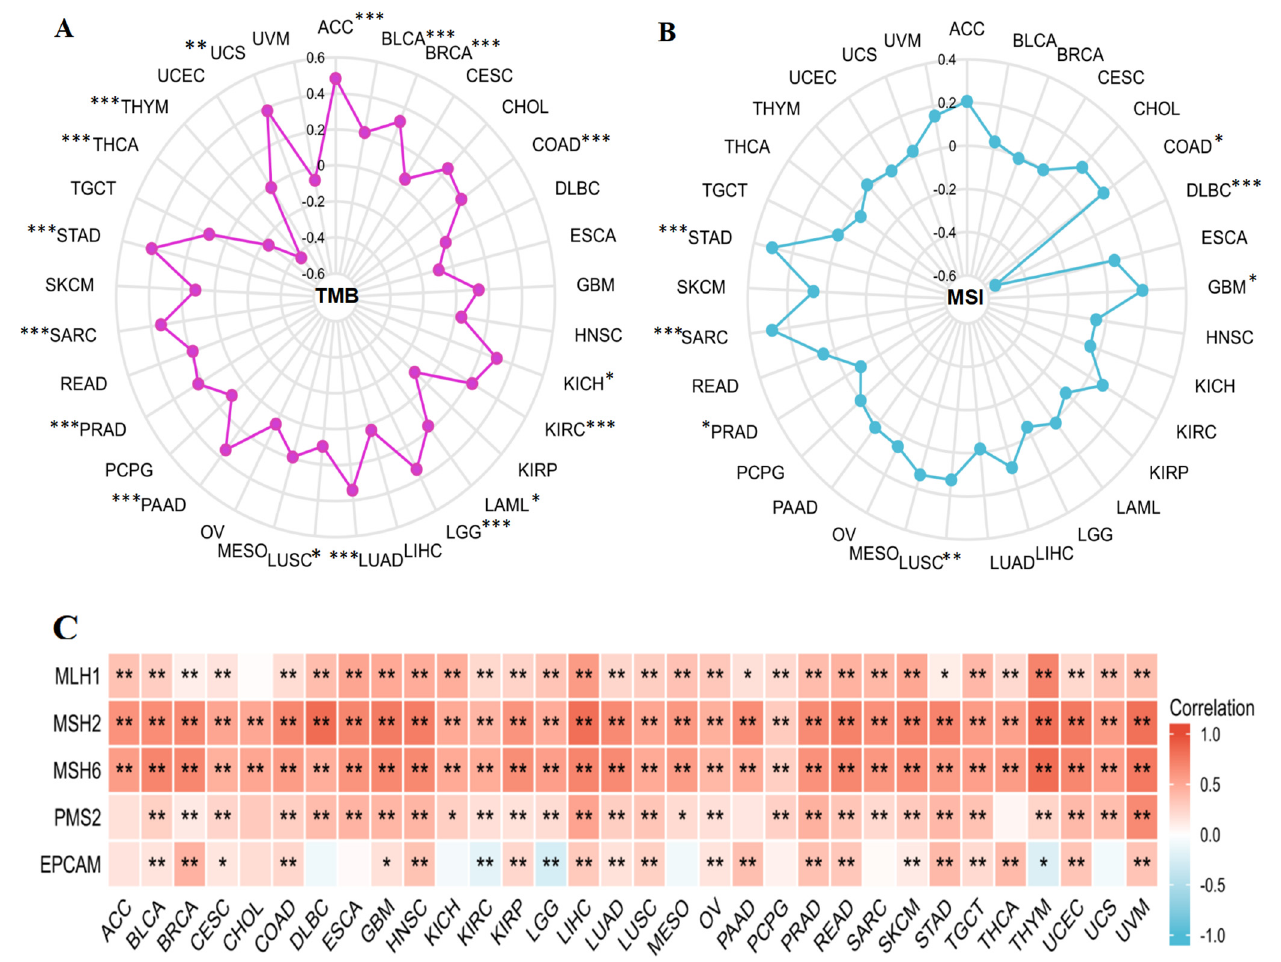
Figure 7. The correlation of KIF18A expression with TMB ( A ), MSI ( B ), and MMRs ( C ). (* p < 0.05,** p < 0.01,*** p <